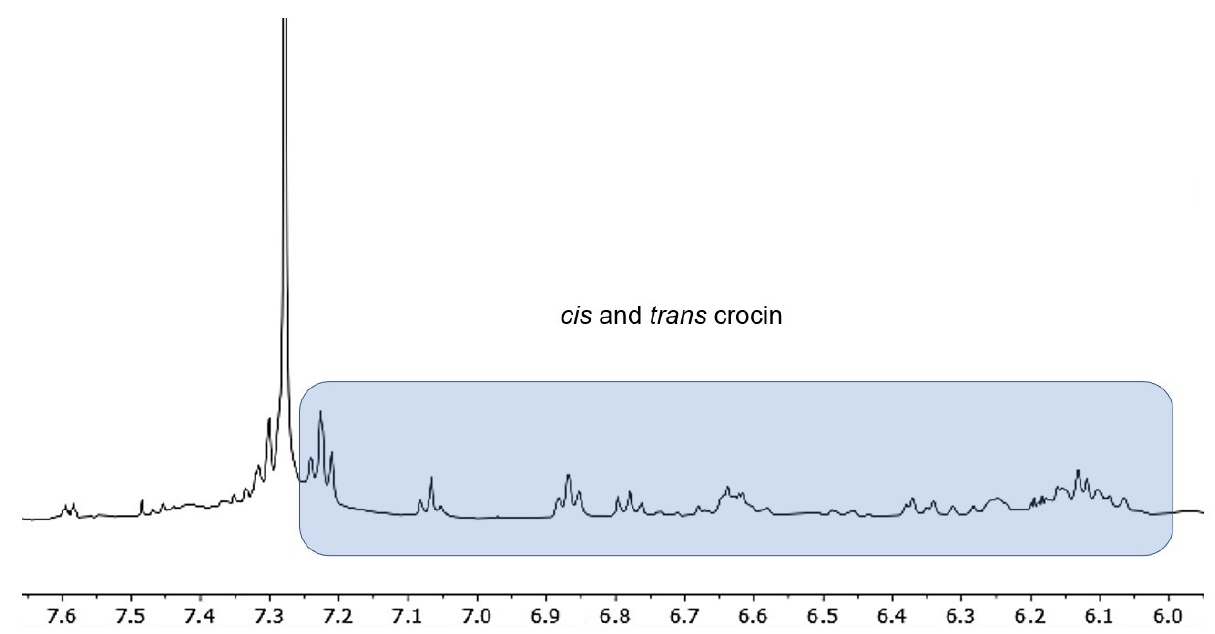
Figure 3. Portion of the 1 H NMR spectrum indicating the presence of crocin.